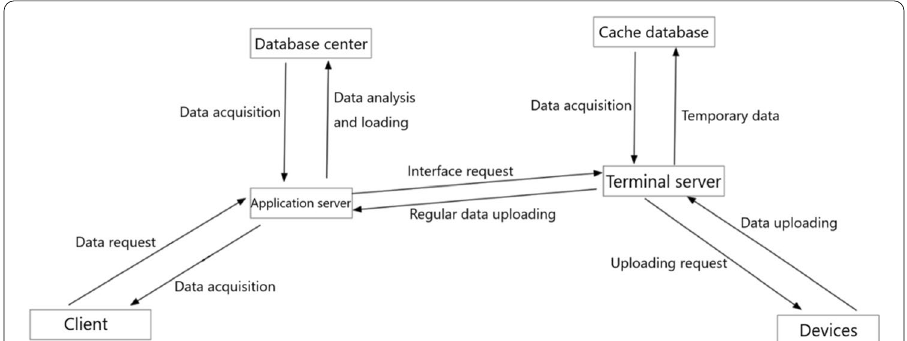
Fig. 7 Monitoring data flow architecture